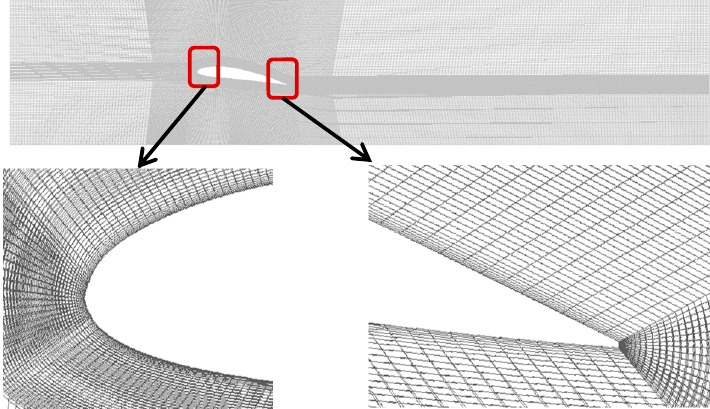
Figure 2. Hydrofoil calculation domain meshes and local encryption graphics.